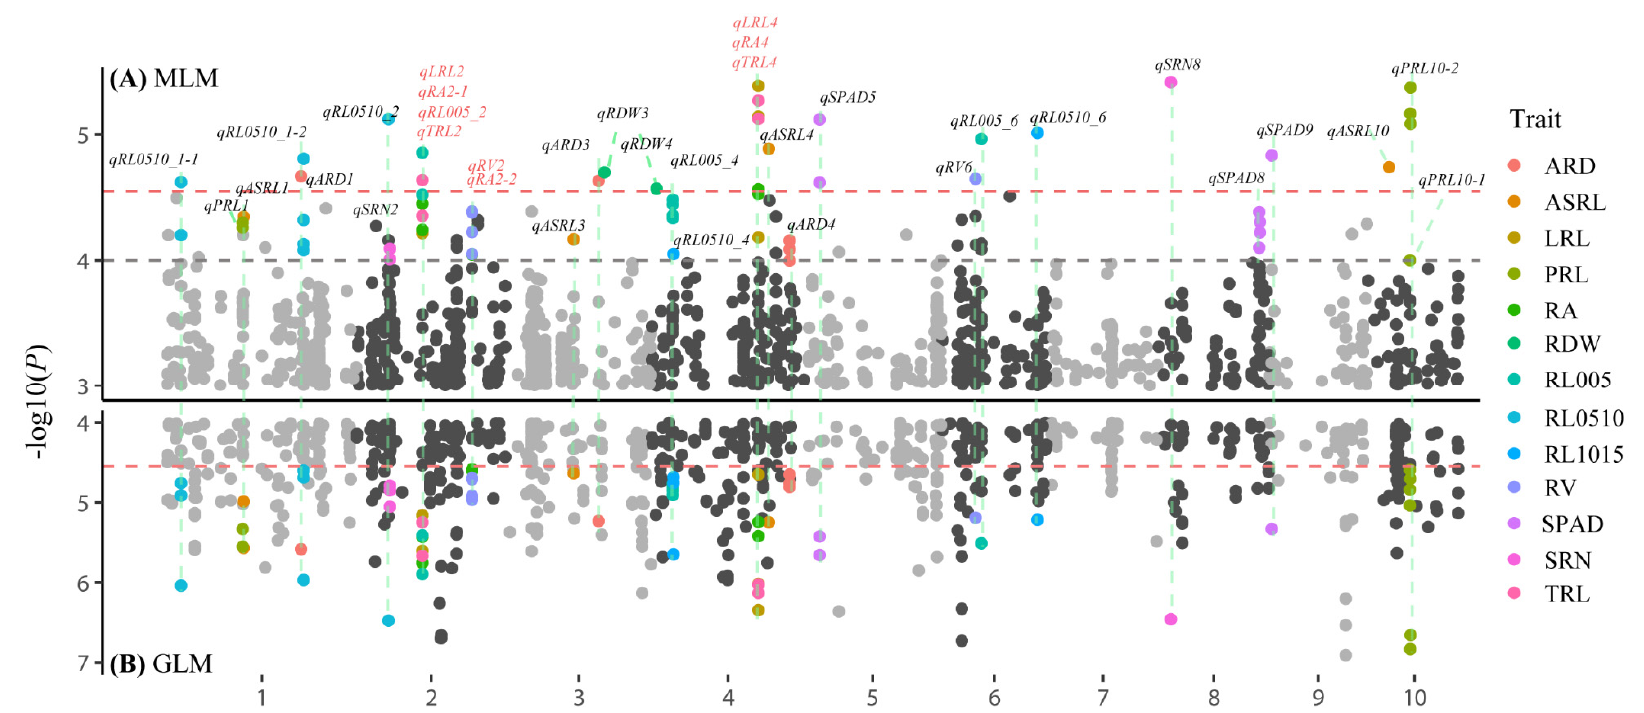
Figure 2. Manhattan plots of mapped single nucleotide polymorphisms (SNP) markers associating with each trait. ( A ) Mixed Linear Model (MLM), ( B ) General Linear Model (GLM). Abbreviations for traits are as follows: ARD, average root diameter; ASRL, average seminal root length; LRL, lateral root length; PRL, primary root length; RA, root surface area; RDW, root dry weight; RL005, root length between 0 and 0.5 mm in diameter; RL0510, root length between 0.5mm and 1mm in diameter; RL1015, root length greater than 1 mm in diameter; RV, root volume; SPAD, leaf chlorophyll concentrations measured by SPAD-502 PLUS chlorophyll (Minolta, Japan); SRN, seminal roots numbers; TRL, total root length.